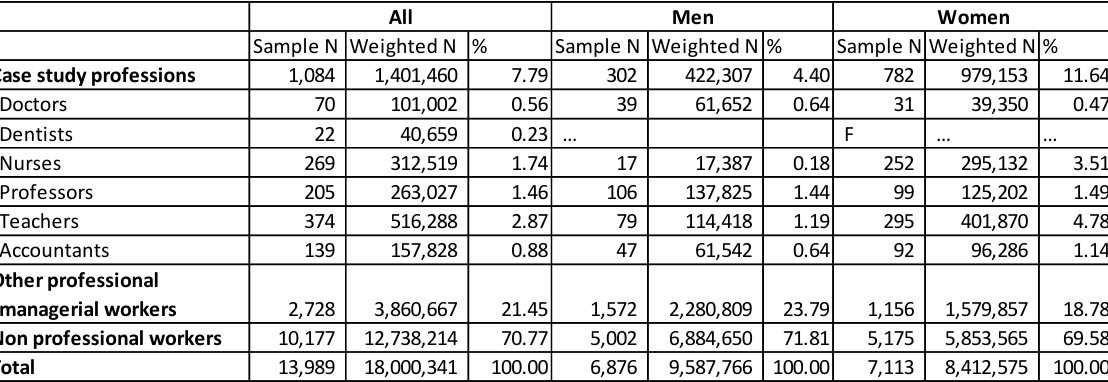
Table 2. Occupational distribution of case study professions, aged 15+, Canada, 2012.